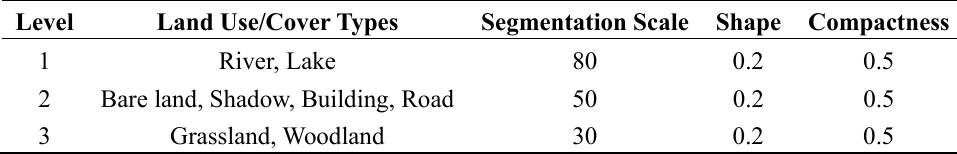
Table 1. Parameter settings for multi-scale segmentation of GE